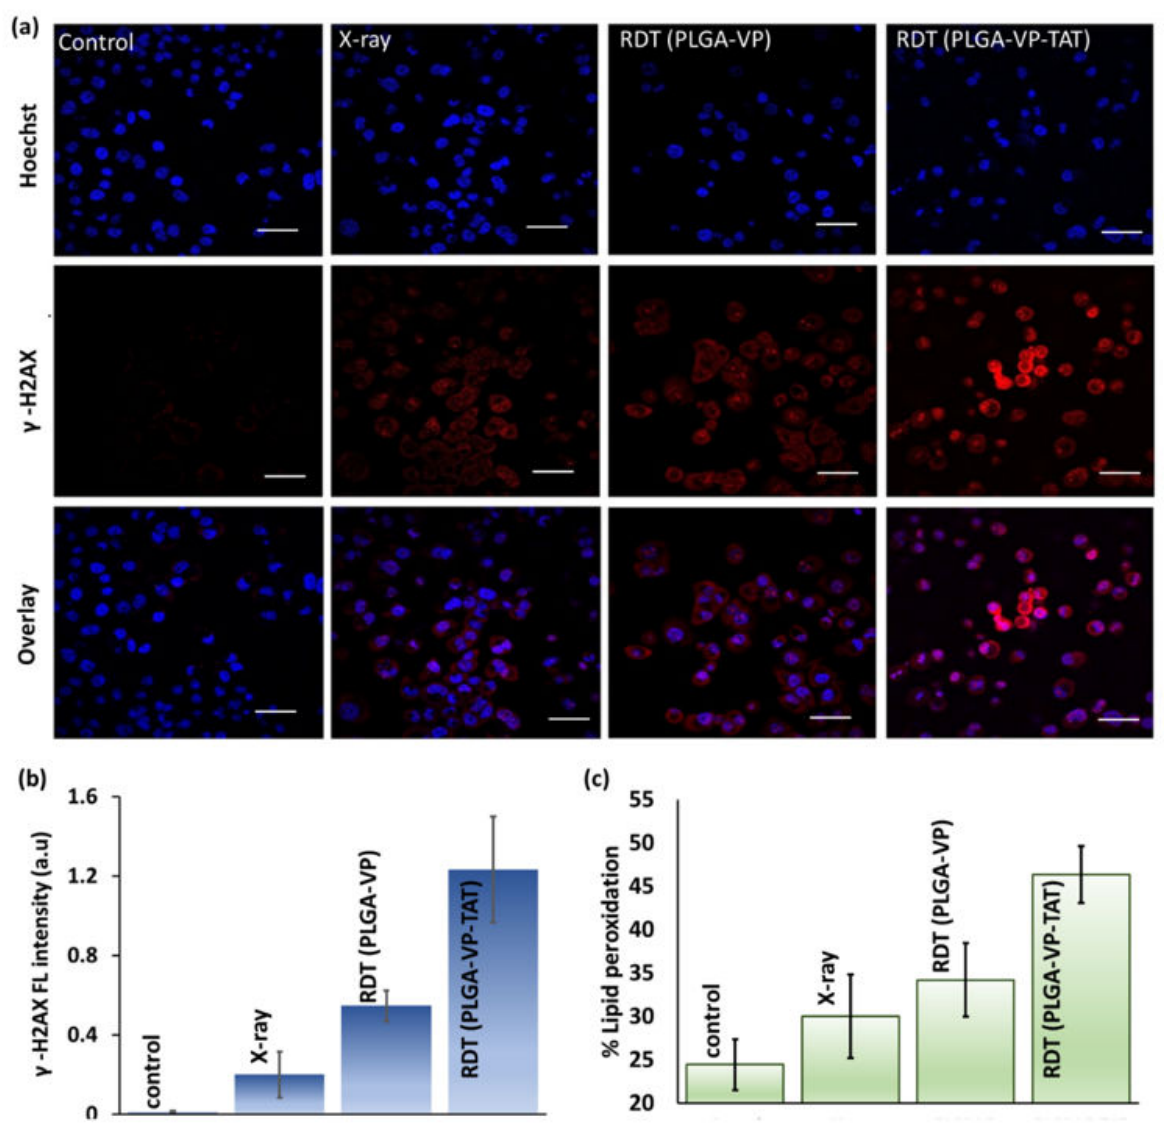
Figure 4. RDT effects at the cellular level. ( a ) representative confocal microscopy images showing DNA double strand breaks indicated by γ -H2AX staining (red: γ -H2AX, blue: Hoechst nuclear stain), ( b ) quantification of γ -H2AX fluorescence, ( c ) lipid peroxidation in the treatment and control groups. Scale bar: 50 µ